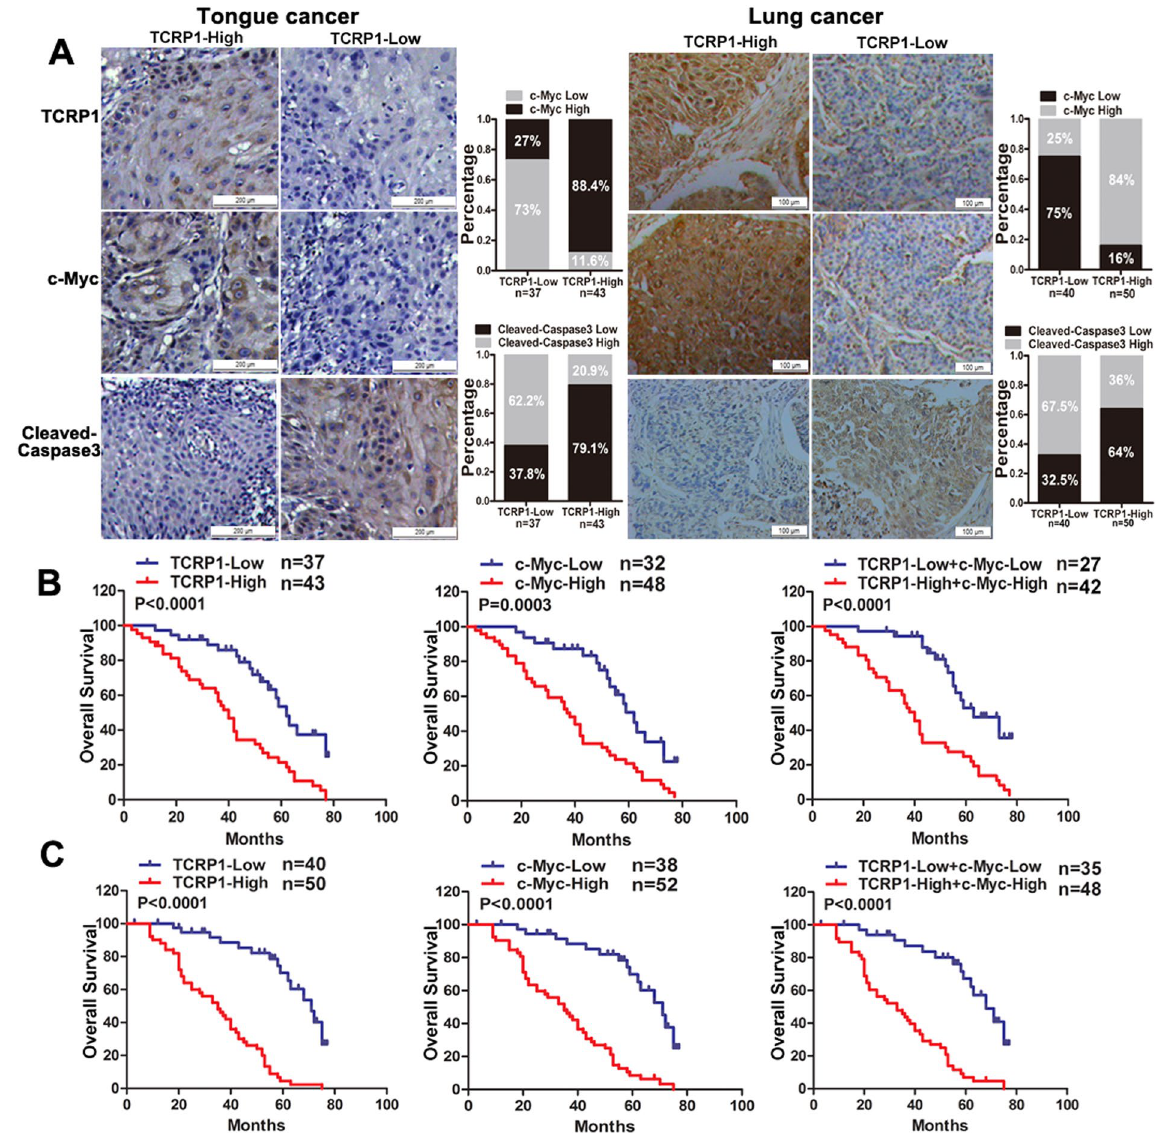
Figure 3. c-Myc positively related with TCRP1 and poor clinical outcome of patients. ( A ) Immunohistochemical assay was used to obtain c-Myc, TCRP1 and cleaved-caspase 3 expression in tongue and lung cancer tissues. Representative images of each protein expression was showed, and the relative expression pattern between TCRP1 and c-Myc or cleaved-caspase 3 were also analyzed. In tongue cancer tissues ( B ) and lung cancer tissues ( C ), Kaplan–Meier analysis was performed to estimate OS according to the protein level of TCRP1, c-Myc, even both